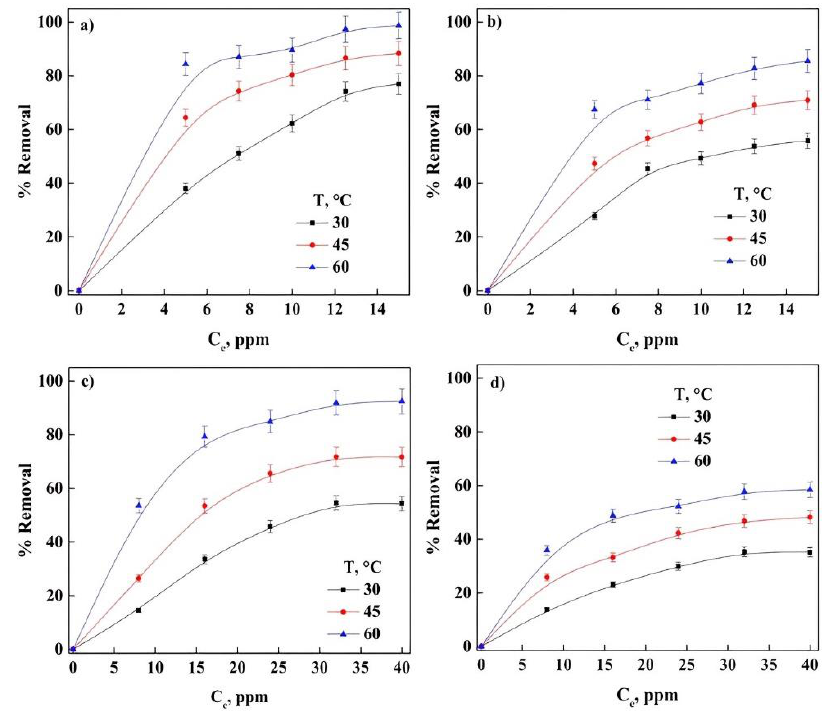
Figure 2. Effect of initial concentration of dyes: ( a ) WLW-PR, ( b ) NWL-PR, ( c ) WLW-GV and ( d ) NWL-GV.